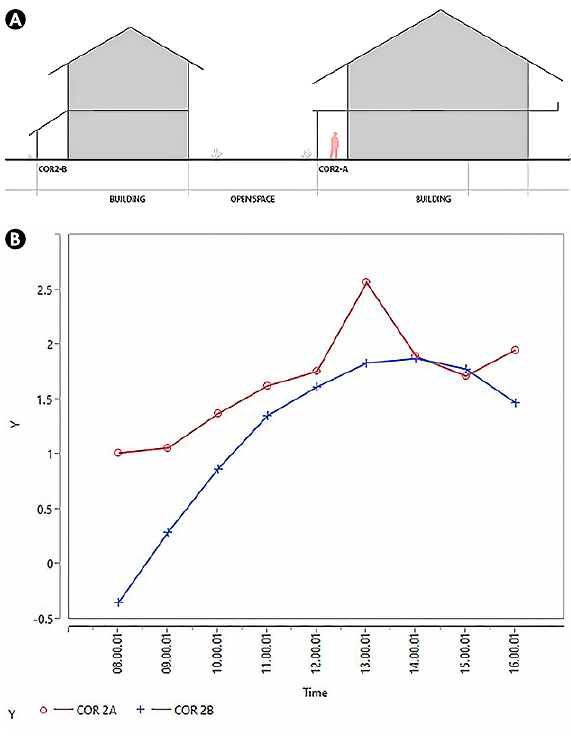
Figure 13. (a) Section of COR2A and COR2B (b) Comparison of PMV at 2 points location in the COR2